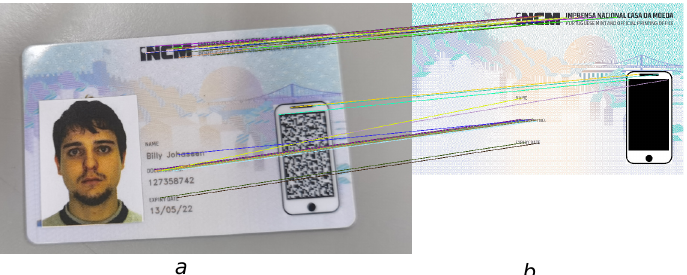
Figure 6. Rectification process with the featured detected by the document appearance: ( a ) captured document image; and ( b ) original card